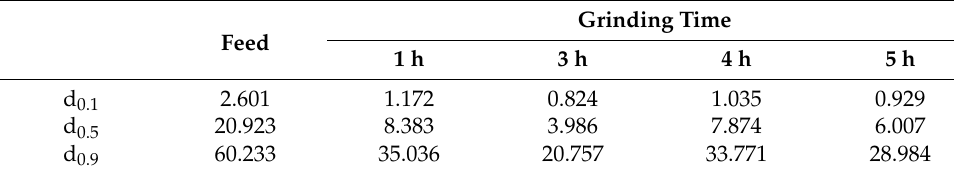
Table 4. Calculated specific surface of samples.